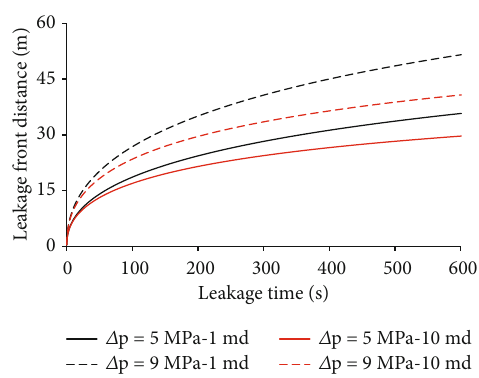
Figure 19: Leakage front distance under di ff erent formation permeability and well bottom di ff erential pressure.